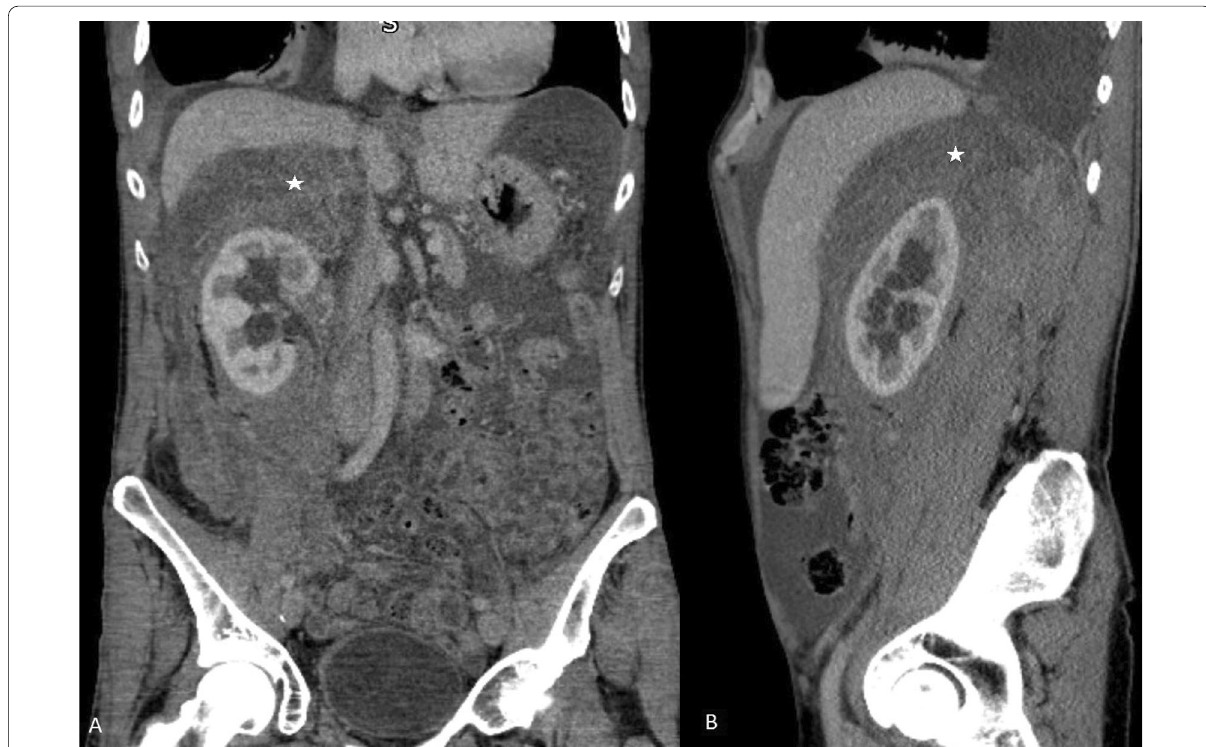
Fig. 17 67-year-old male with biphasic type of malignant peritoneal mesothelioma. a , b CT coronal and sagittal reformatted images showing right perinephric soft tissue density mass (*), right hydronephrosis and ascites. This patient also had concurrent right intra-thoracic disease